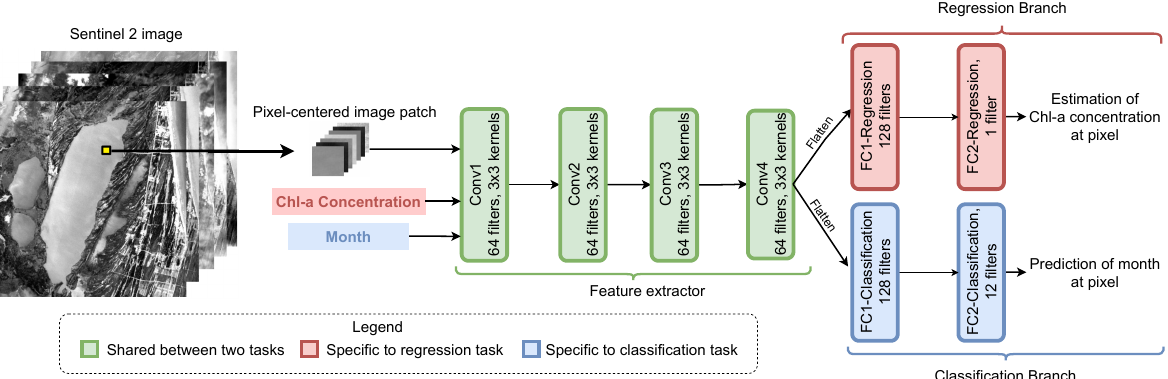
Figure 3. The outline of the proposed multitask learning CNN architecture where Conv and FC denote convolutional layer and fully connected layer,